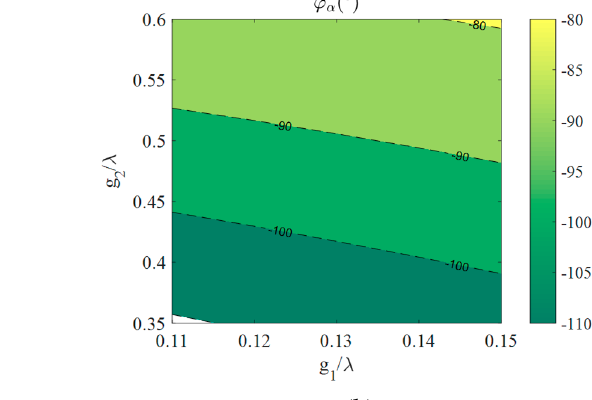
| αλ | √ , shown in Figure ω C λ